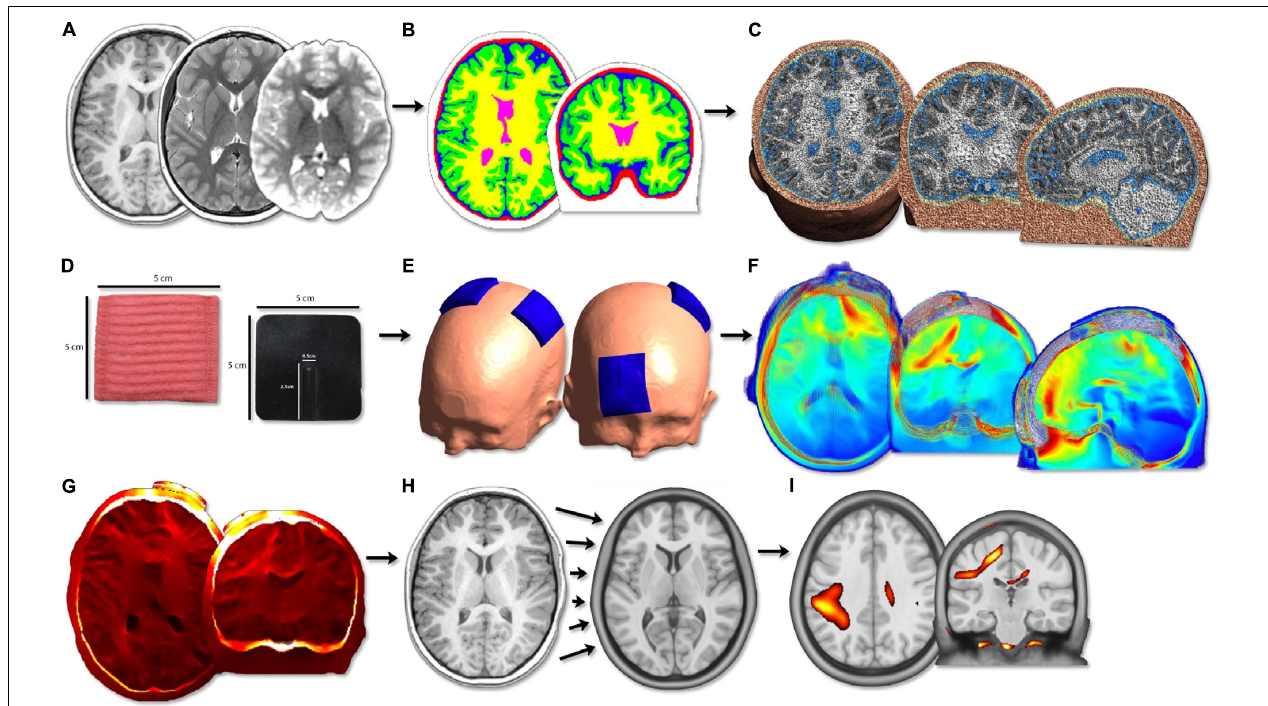
FIGURE 1 | Image processing flow diagram. (A) Acquisition of T1, T2 anatomical and diffusion scans. (B) Segmentation of T1 anatomical image into five tissue types. (C) Calculation of head volume meshes composed of tetrahedral elements. (D) Modeling of 5 cm × 5 cm virtual tDCS electrodes. (E) Simulation of three typical tDCS montages aimed at motor learning (anodal, cathodal, bihemispheric). (F) Modeling of electric field strength across the brain. PeakEF was extracted for each montage, tissue type, and age group. (G) Conversion of EFMaps into NIfTI format by interpolating tetrahedral elements. (H) Normalization of NIfTI files into MNI template space using deformations calculated on T1 anatomy. (I) Voxel-based statistical analyses were performed using